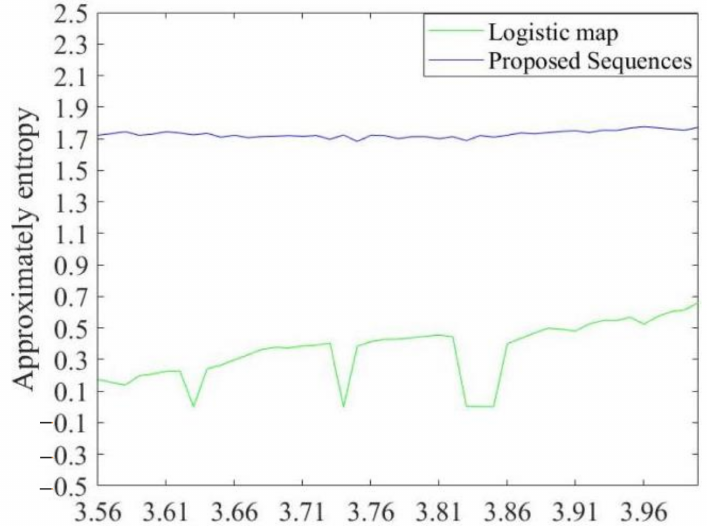
Figure 4. Approximate entropy of x -dimensional proposed sequence and Equation (1).